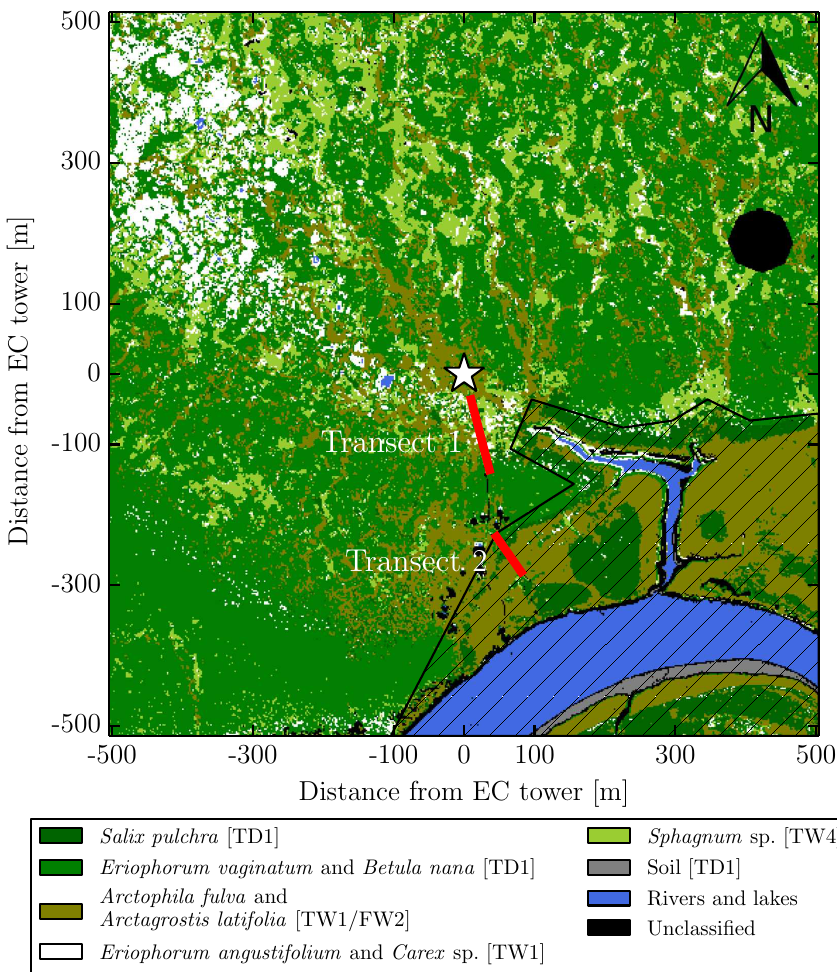
Figure 4. Vegetation map. Hatched area represents the area where the Arctophila fulva and Arctagrostis latifolia vegetation type was assigned to the FW2 class. Location of the EC tower is marked with a white star. Chamber flux measurements for classes TW1, TW4 and TD1 were done along Transect 1, and for FW2 class along Transect